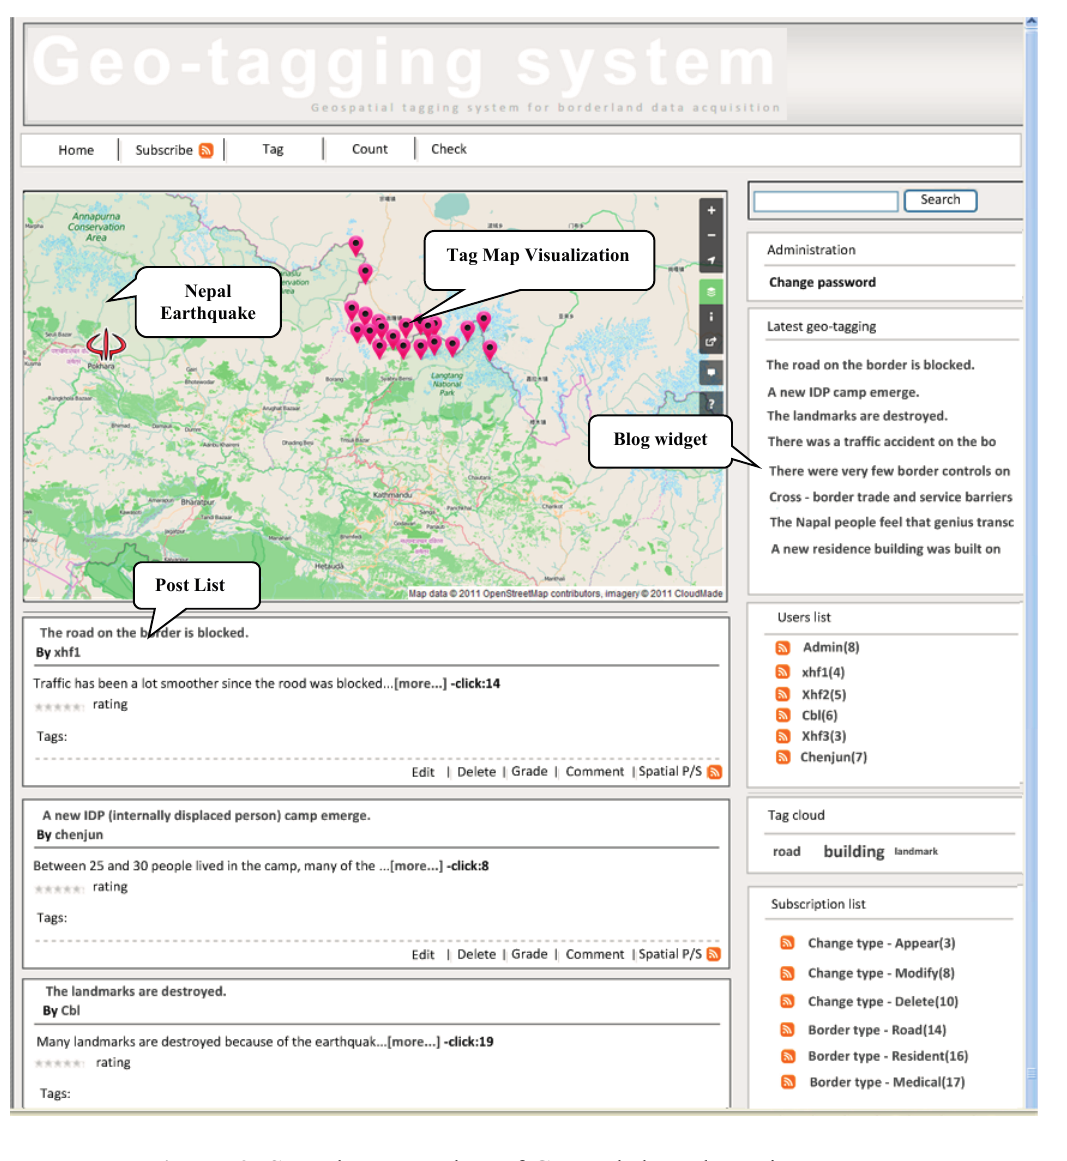
Figure 9. Sample screenshot of Geoweb-based tagging